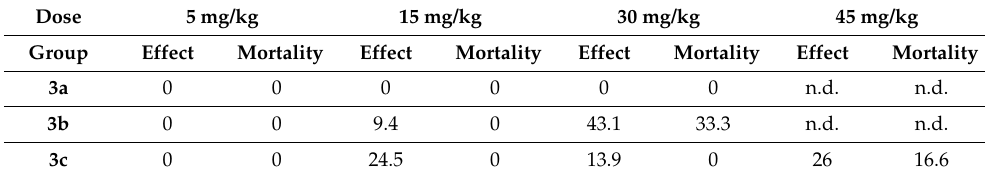
Table 1. Evaluation of compounds 3a – c in OGTT. Data represented as a difference of area under the glycemic curve (AUC) in % from control mice (glucose load only) in the relevant experiment. Each group n = 6. n.d.—no data.